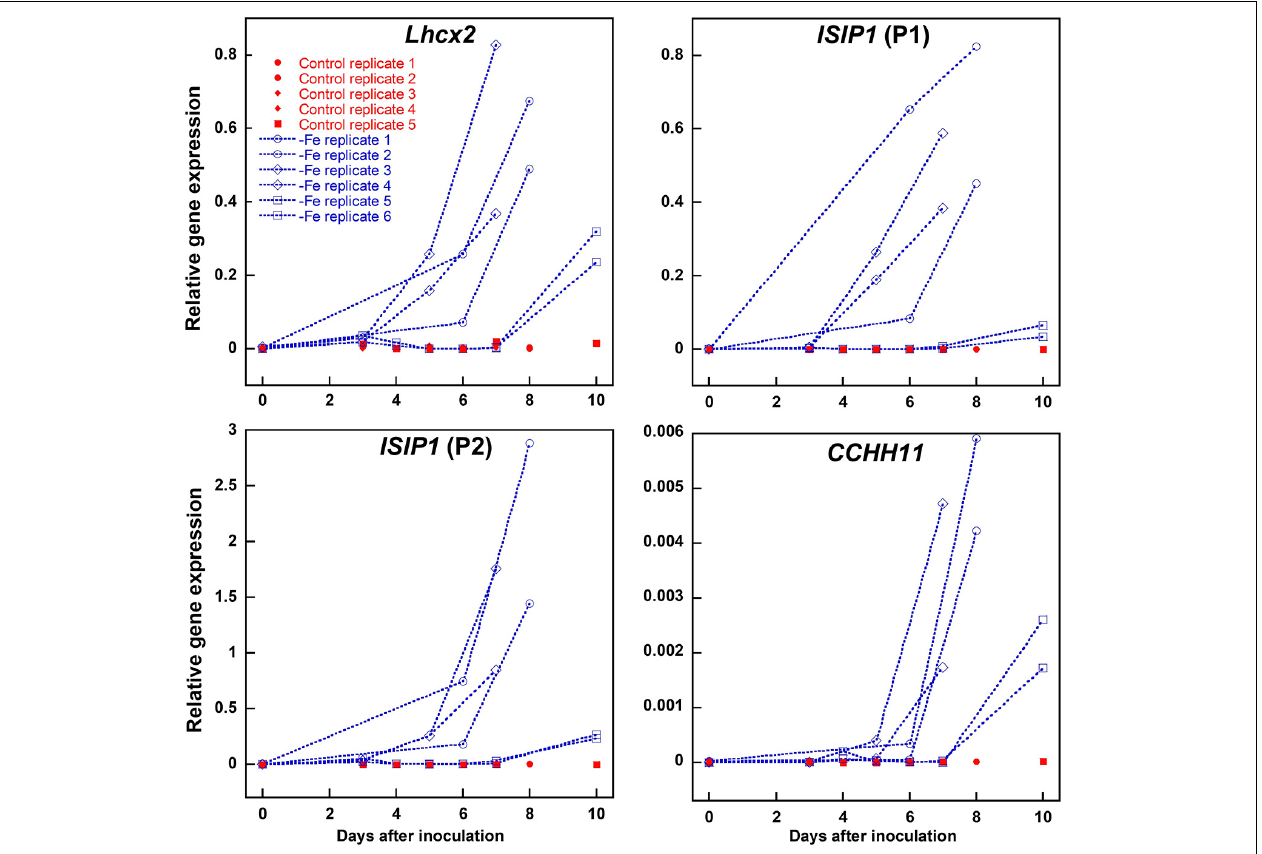
FIGURE 2 | Comparison of Lhcx2 expression with expression of ISIP1 and CCHH11 in an iron-depleted medium in Phaeodactylum tricornutum wild type cells. ISIP1 was tested with two different primer pairs (P1 and P2) targeting the same transcripts. Measurements under iron limitation are shown in blue. Controls shown in red were treated the same way, but iron was added in a concentration like in a standard F/2 medium. Expression rates were normalized to expression of 18S . Points with the same shape are technical replicates inoculated from the same